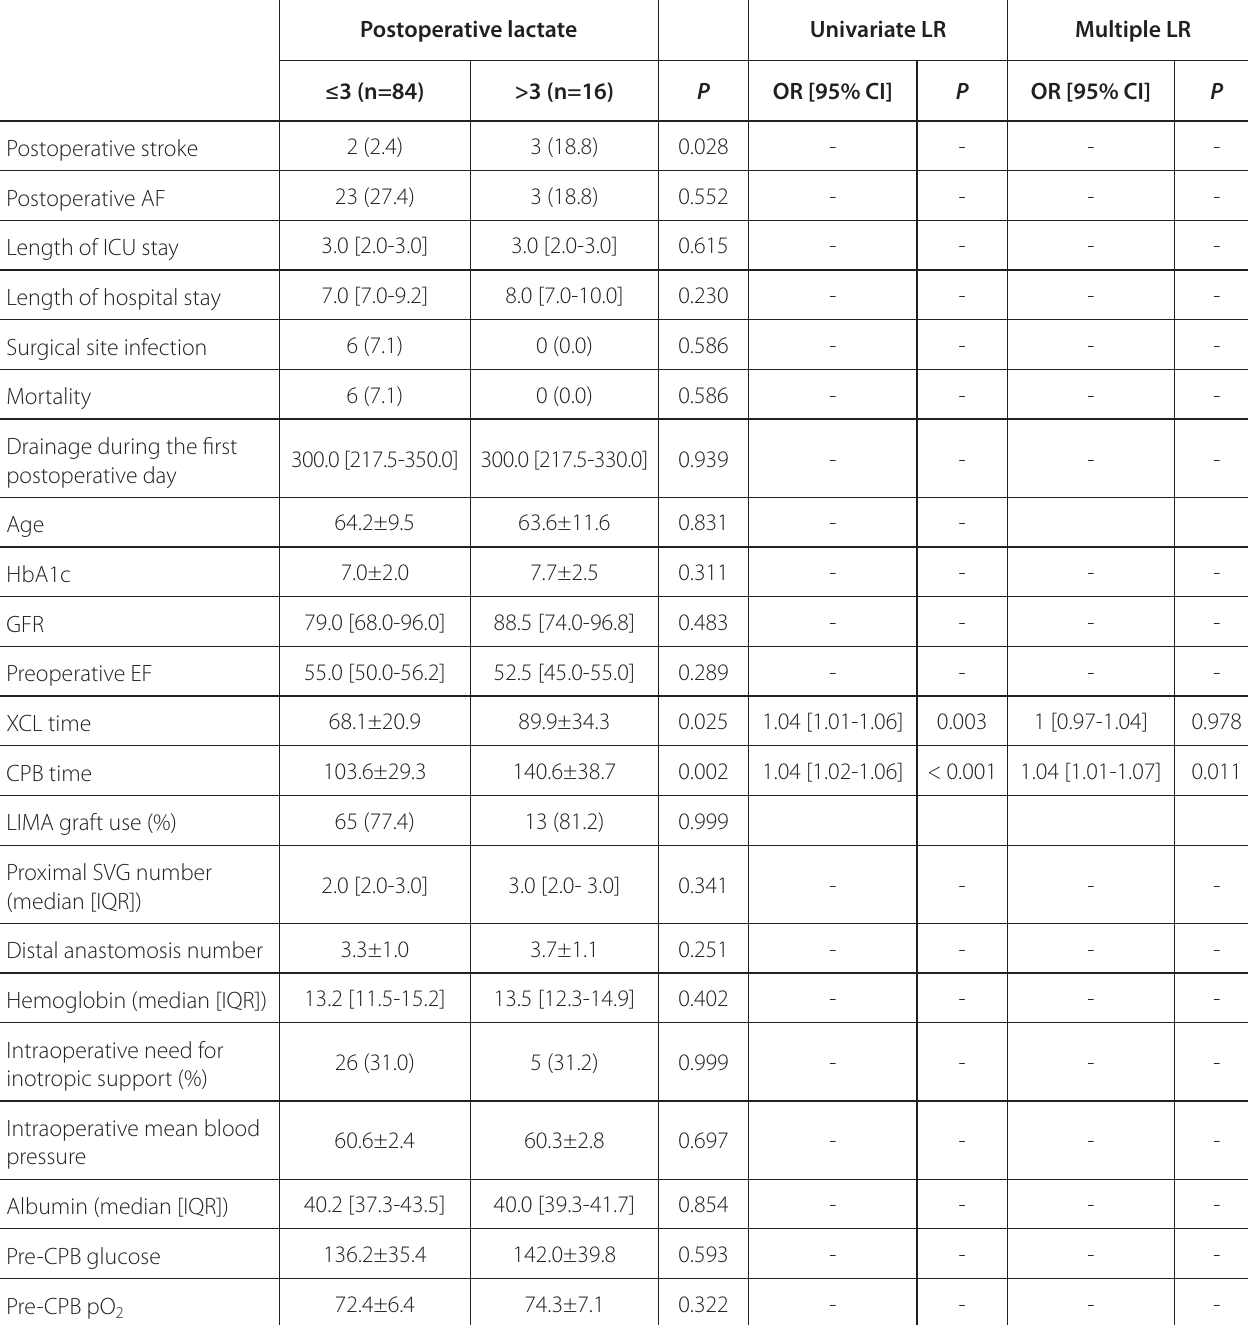
Table 3 . Comparison of postoperative complications, intraoperative characteristics and some laboratory features among patients with postoperative serum lactate levels above and below 3